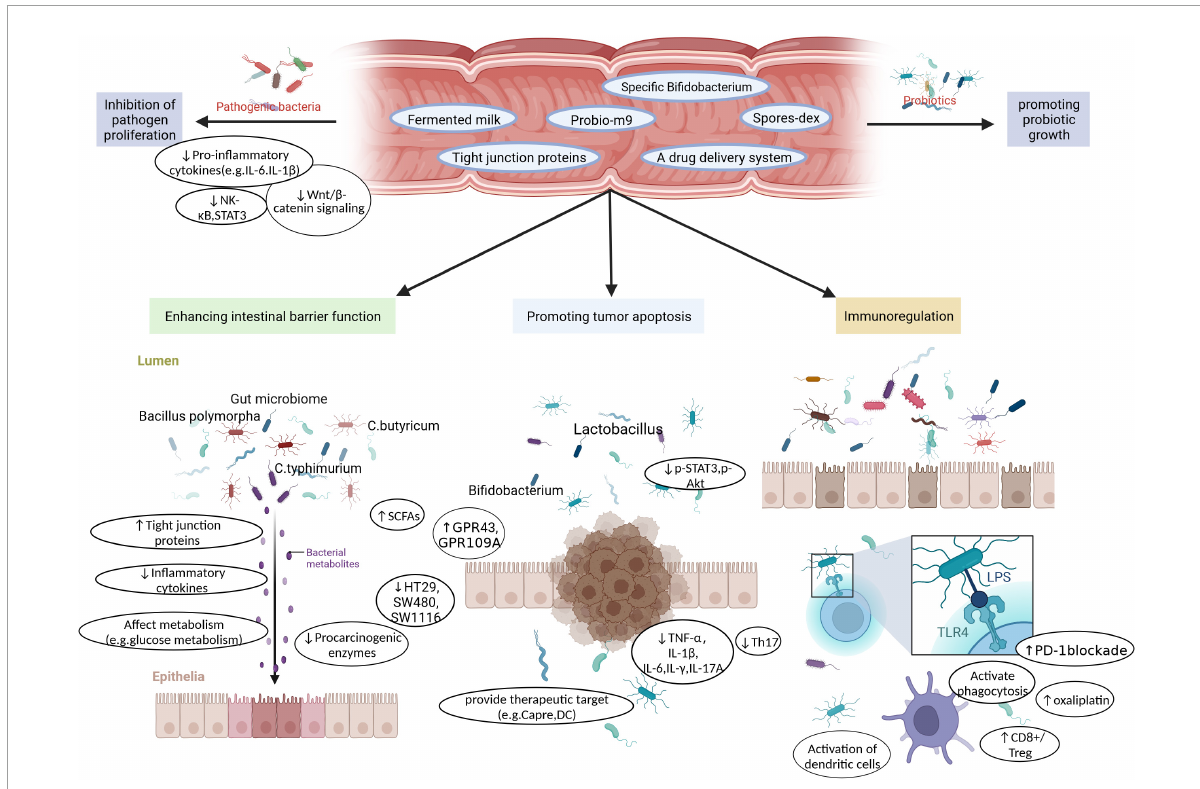
FIGURE3 Probiotics as functional factors, such as Fermented milk, Probio-m9, specific Bifidobacterium, Spores-dex, Tight junction proteins, a drug delivery system, not only increase the proliferation of beneficial bacteria. It also inhibits the growth of pathogenic bacteria by inhibiting Pro-inflammatory cytokines, down-regulating Wnt/ β -catenin signaling, inhibiting NK- κ B and STAT3. Furthermore, various probiotic strains play a role in enhancing intestinal barrier function, promoting tumor cell apoptosis, and enhancing immune regulation through unique or common functions, to achieve the purpose of prevention or treatment of